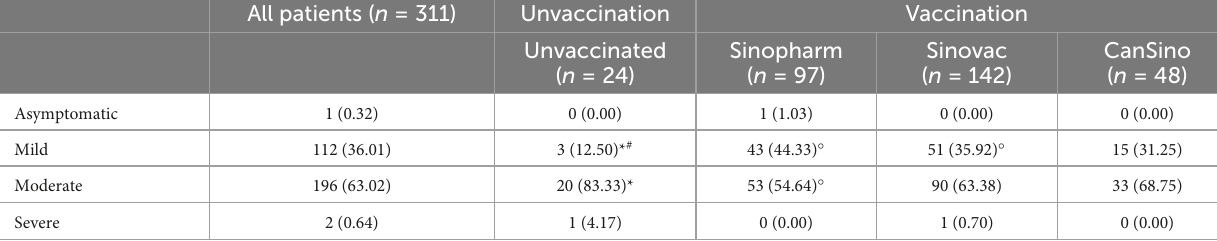
TABLE 3 Clinical classifications of adult patients in different groups. All patients ( n =